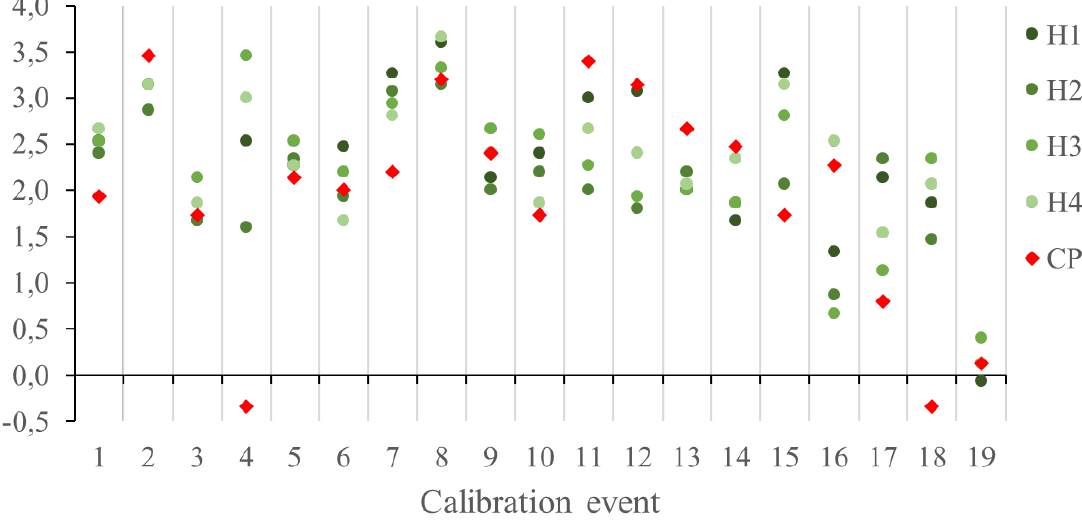
Figure 8 Detection of evasive action by the human observers (H1 – 4, green) and the computer algo- rithm (CP, red): calibration